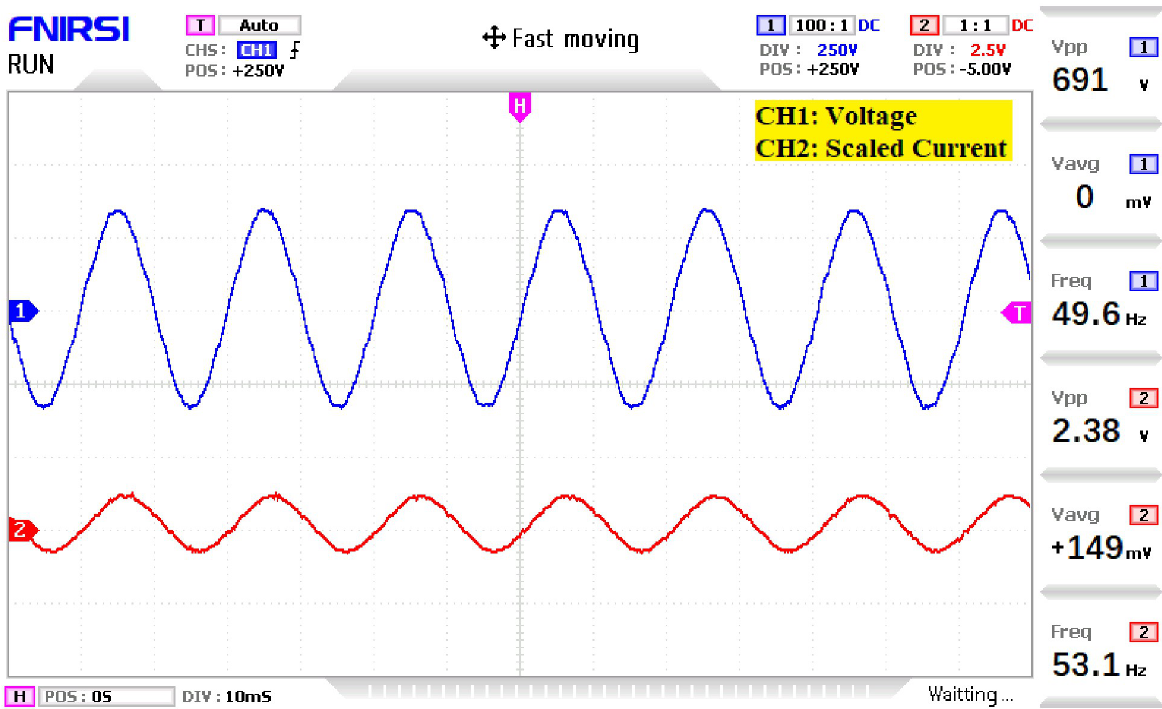
Fig 25. Experimental waveforms (voltage and current) at the output of 81-level MWMLI for MI = 0.85 at 0.9PF lagging load.